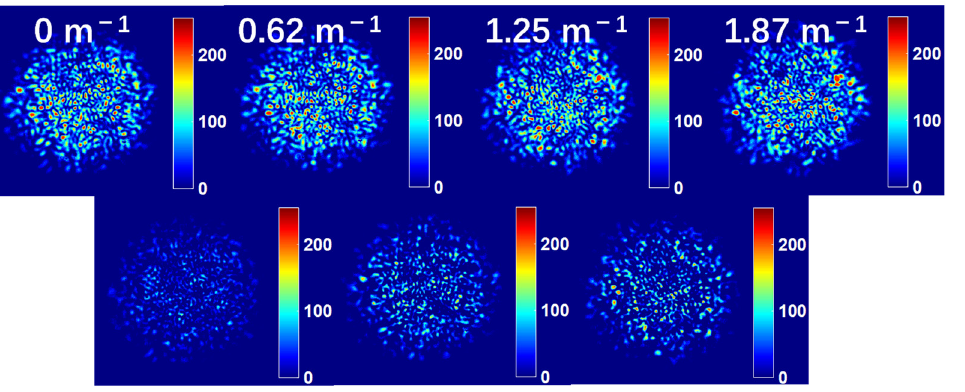
Figure 4. Speckle patterns corresponding to different curvatures collected from position P1 and their differences between the adjacent speckle patterns.